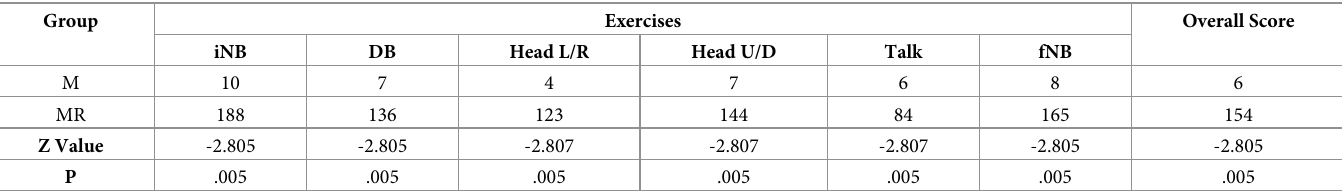
Table 2. Scores of FF of surgical mask with and without retainer.